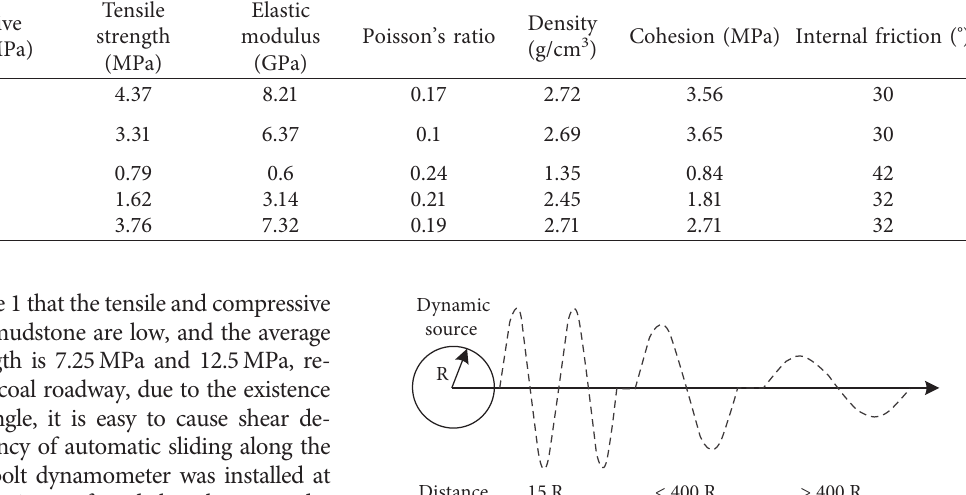
Table 1: Physical and mechanical parameters of rock specimens from the Yineng coal mine. Lithology